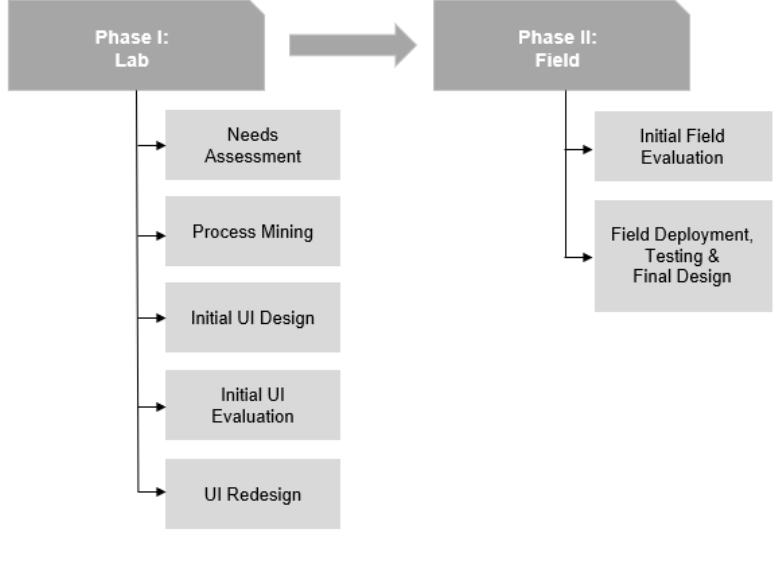
Figure 2. Overview of the methods used to design, develop, and evaluate myED . UI: user